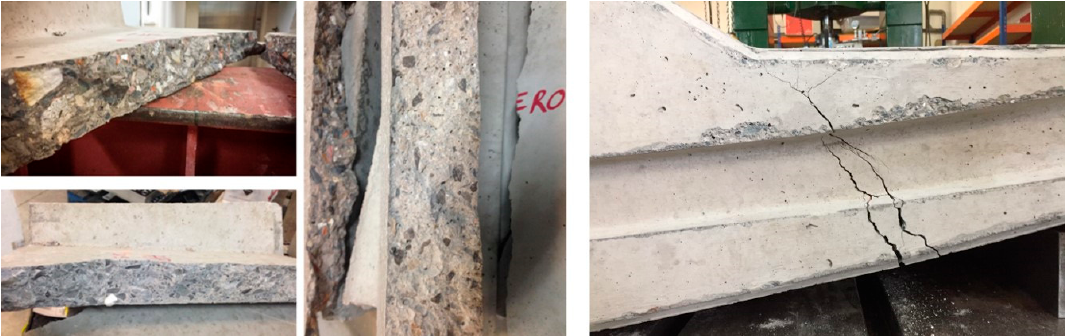
Figure 11. Precast test and cracking.